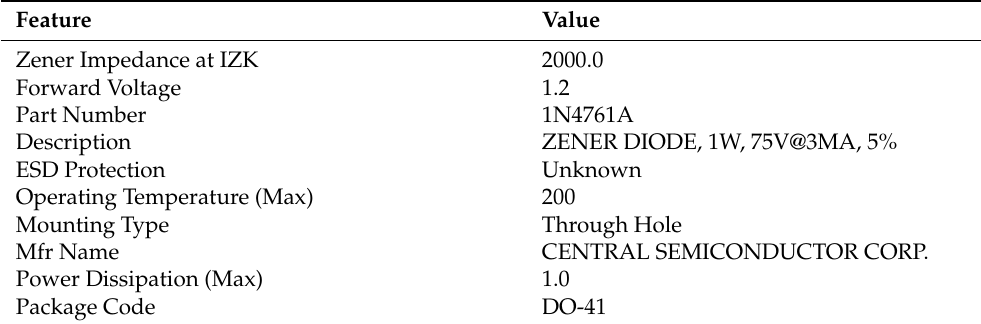
Table 2. Example of data collected for a Zener